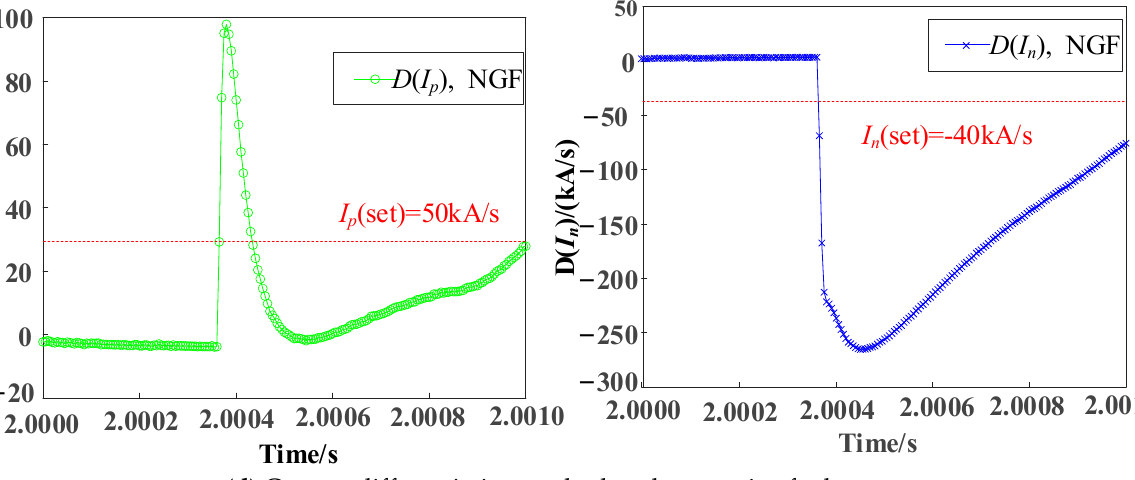
( d ) Current differentiation method under negative fault